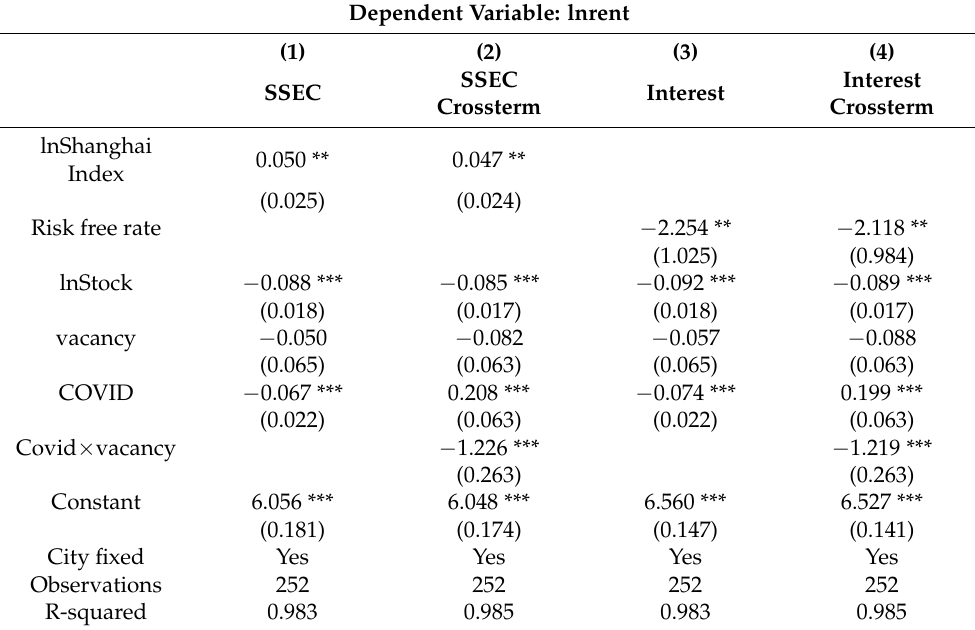
Table 8. Robust tests for office rent